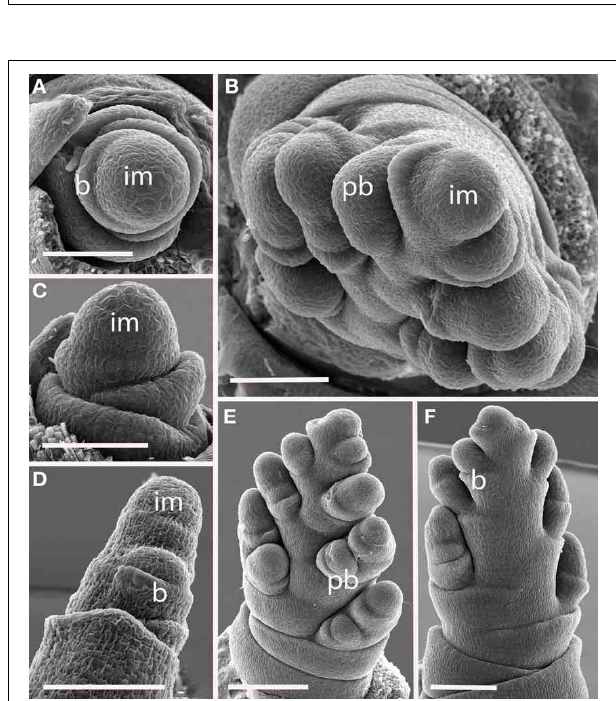
FIGURE 7 | Diarrhena obovata (Diarrheneae). (A,C) Inflorescence meristem shortly after the transition to flowering; (D) initiation of a primary branch in the axil of a bract; (B,E,F) later development showing formation in primary branches in two, non-distichous, ranks and secondary branches on one side. im, inflorescence meristem; pb, primary branch; b, bract. Scale bars: (A–D) , 100 µ m; (E) , 200 µ m; (F) , 100 µ m.